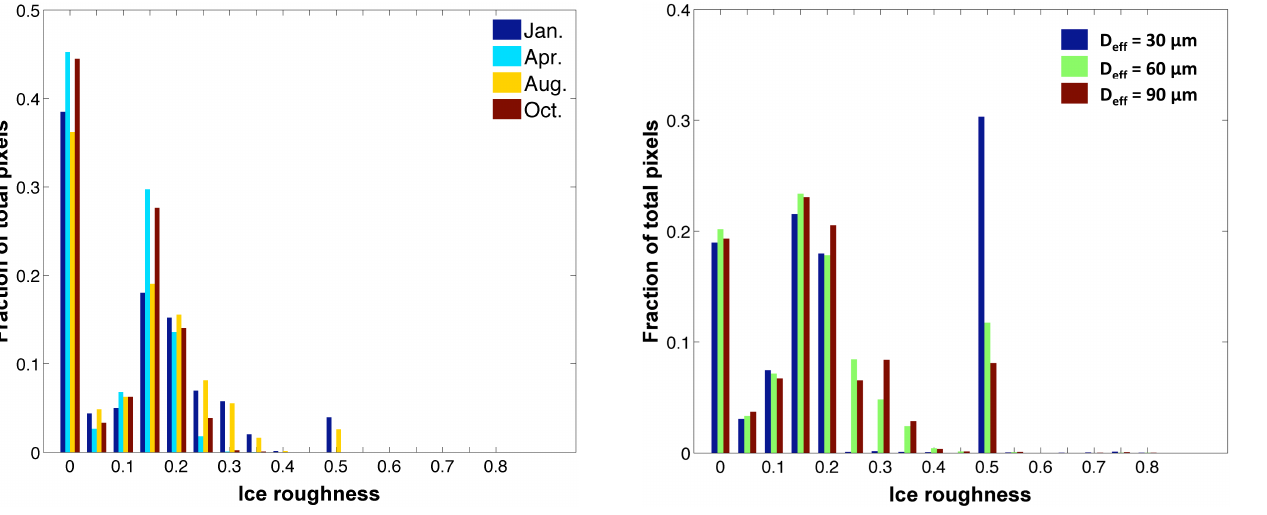
Fig. 9. As in Fig. 6 but for polar regions only. Fig. 10. Ice roughness inferred for 3 effective diameters from data recorded on 1 August 2007, with roughness defined as in Fig.